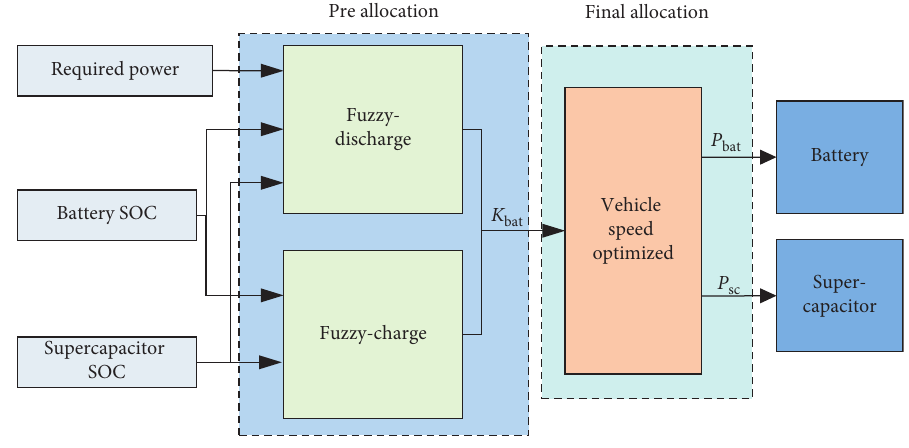
Figure 4: Structure of VSO-FEMS strategy. Table 2: The domain of fuzzy sets.